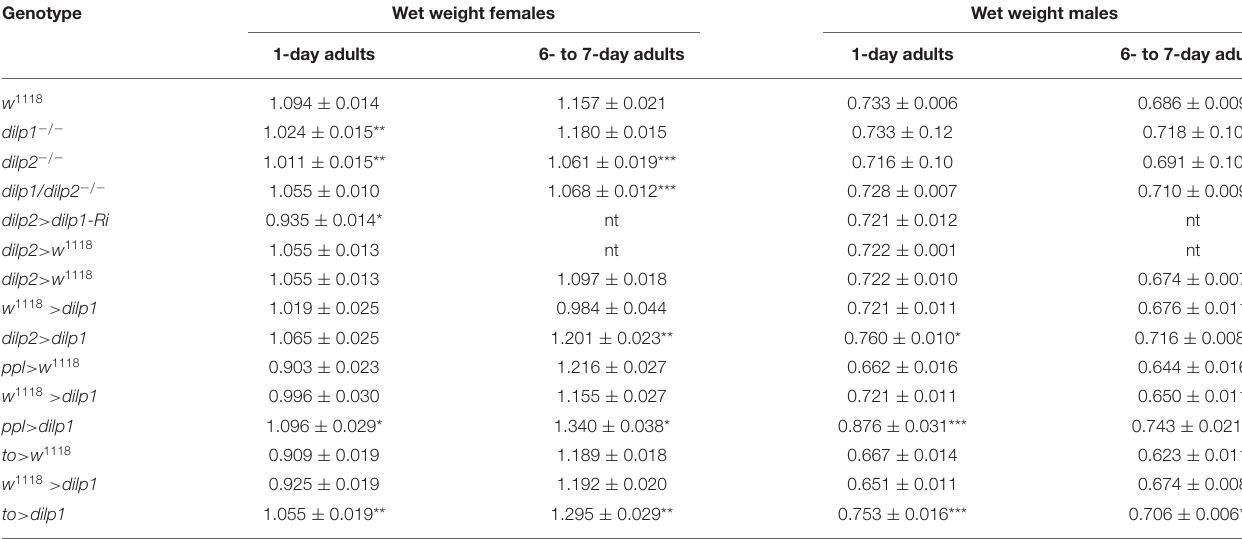
TABLE 1 | Body weights of flies of different genotypes.